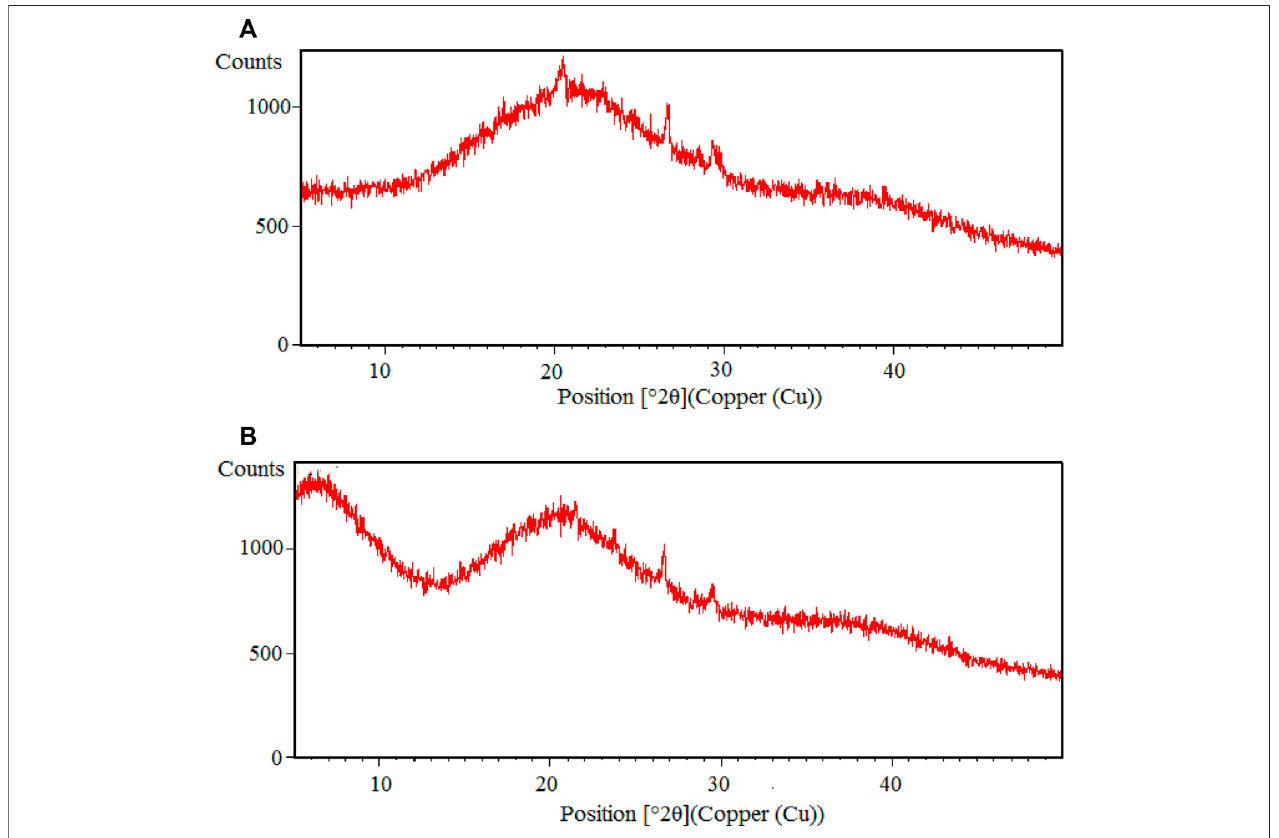
FIGURE 3 | (A,B) XRD of (A) Kg-cl-poly (AA) and (B) Kg-cl-poly